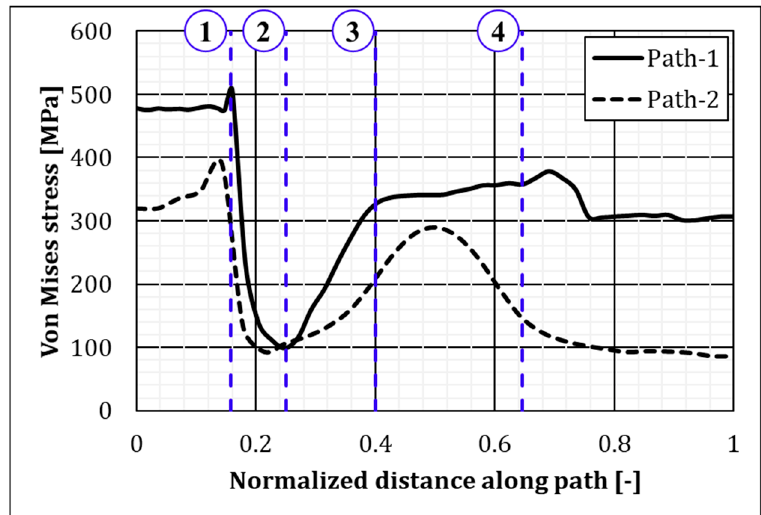
Figure 12. Distributions of von Mises stresses along Path1 and Path2.